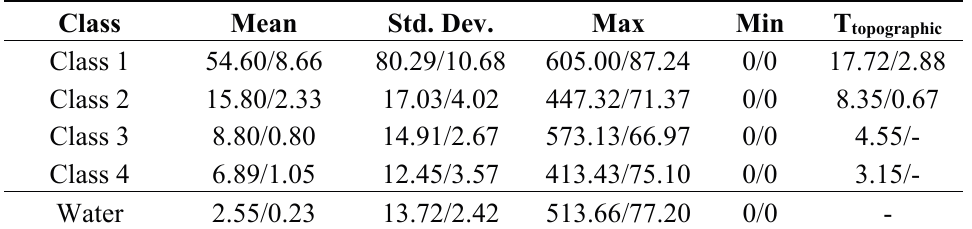
Table 2. Statistics and terrain information threshold values